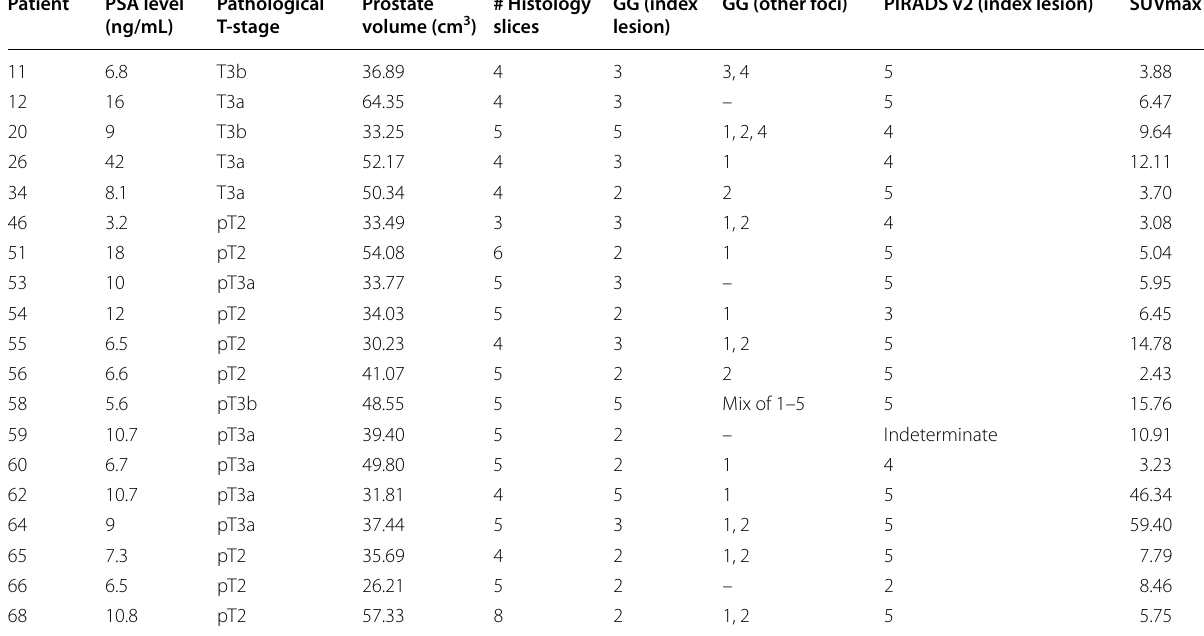
Prostate volume is calculated using the ellipsoid formula from pathology measurements [11] GG Grade group